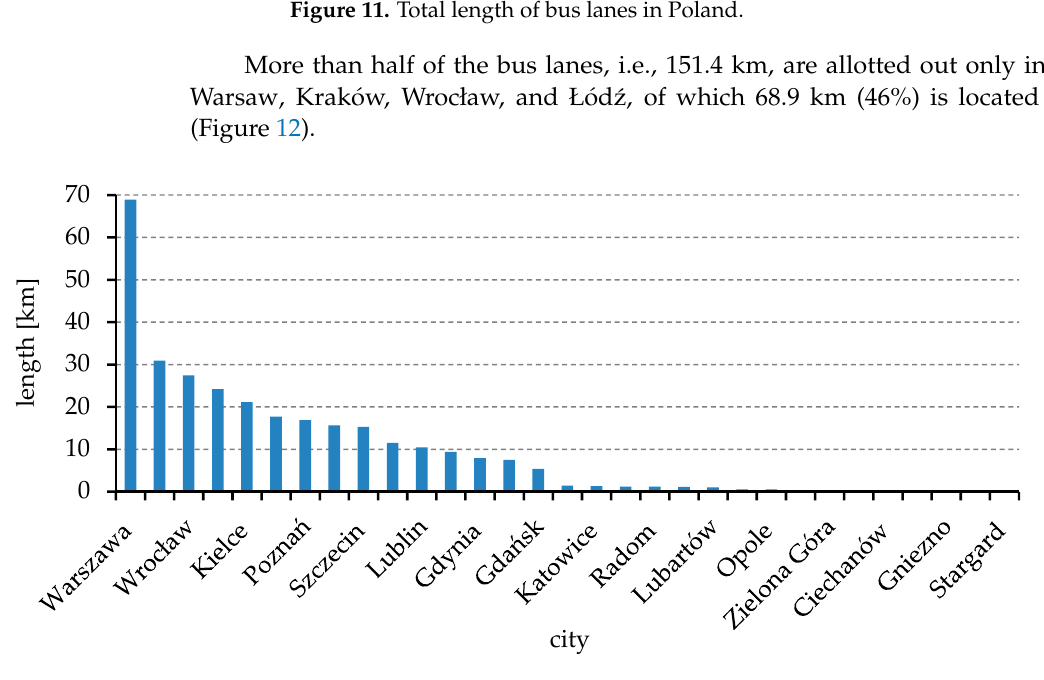
Figure 12. Bus lanes in Poland.